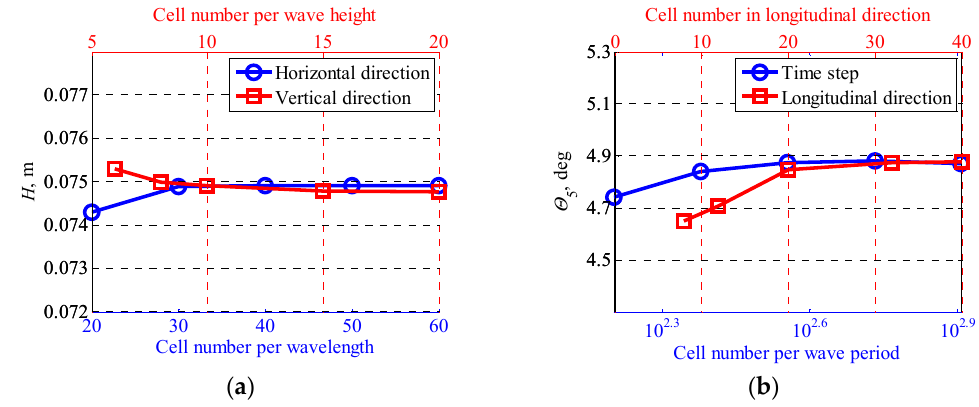
Figure 7. Convergence study results at T = 1.6 s, and H = 0.075 m: ( a ) measured wave height as a function of the cell number per wavelength and per wave height; ( b ) pitch angular displacement amplitude as a function of the cell number in the longitudinal direction and per wave period.